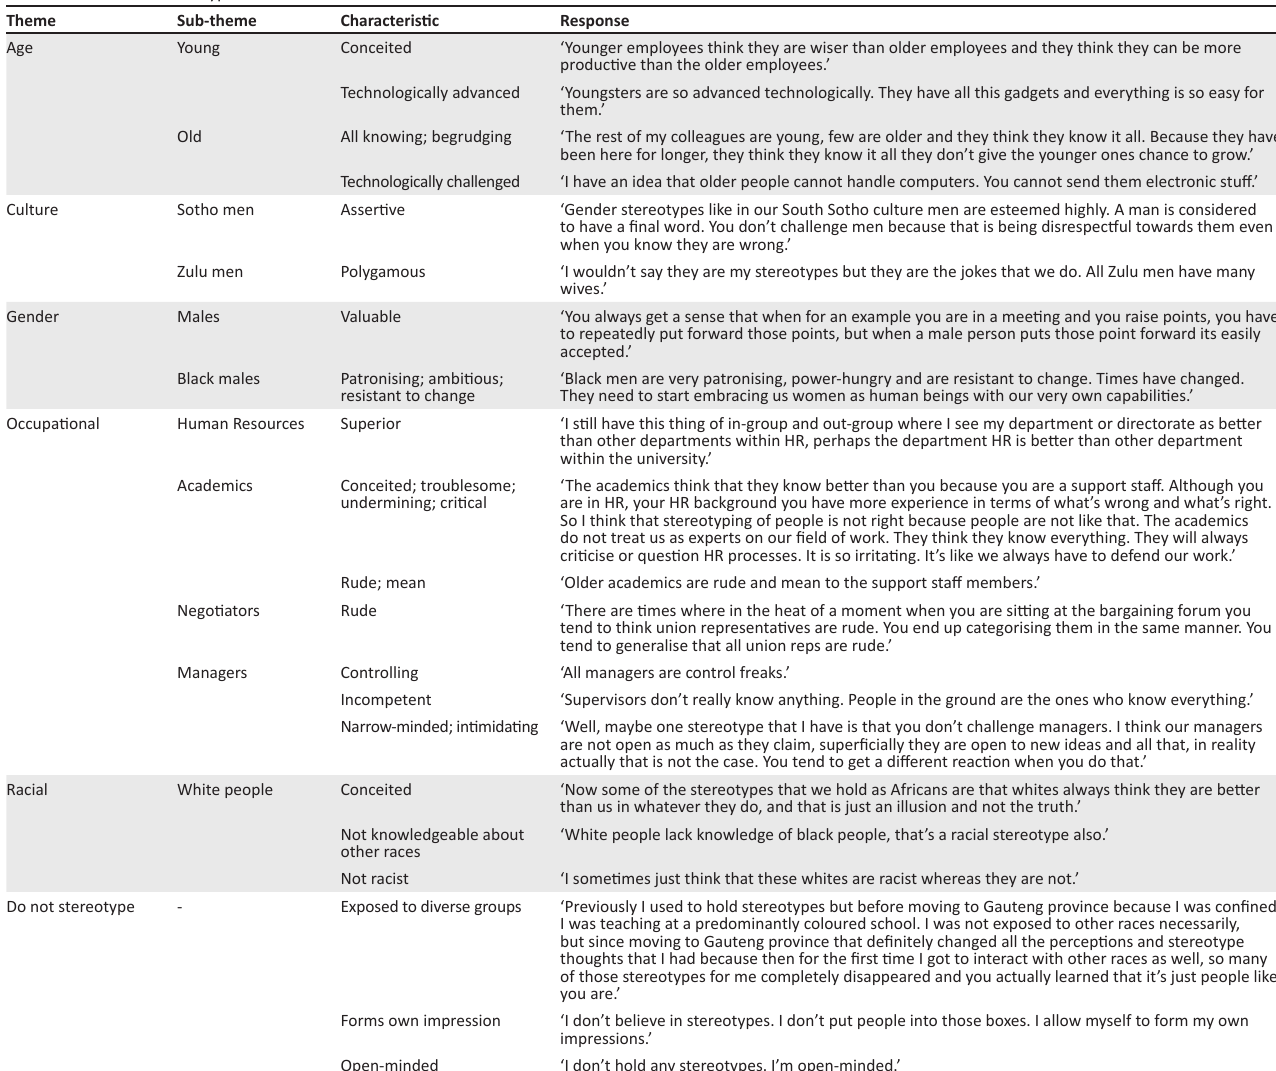
TABLE 3: Perceived stereotypes about